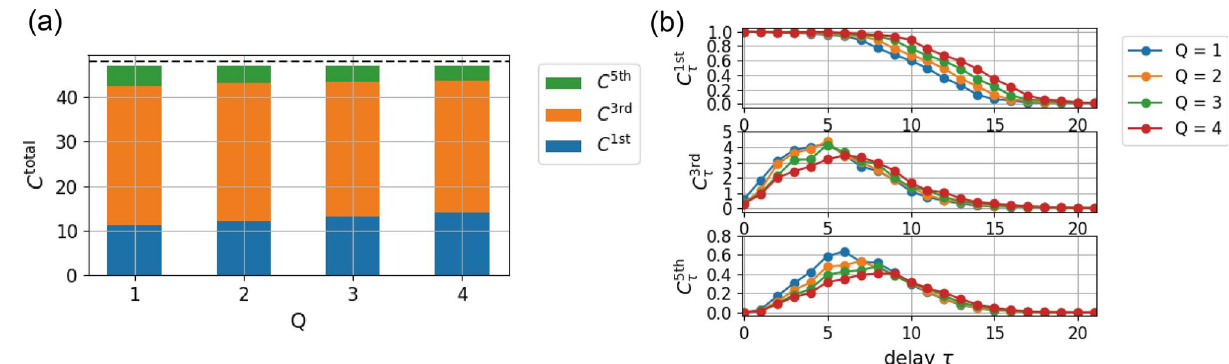
Figure 5. Q -dependence of IPCs. ( a ) IPCs of the RC with delay-state concatenation for various values of Q . ( b ) Delay structures of the IPCs for various values of Q . From top to bottom, the first-, third-, and fifth-order IPCs are shown. The parameters are set as follows: N res = 24 , ρ in = 0.9 , ρ res = 0.95 , and P = 1